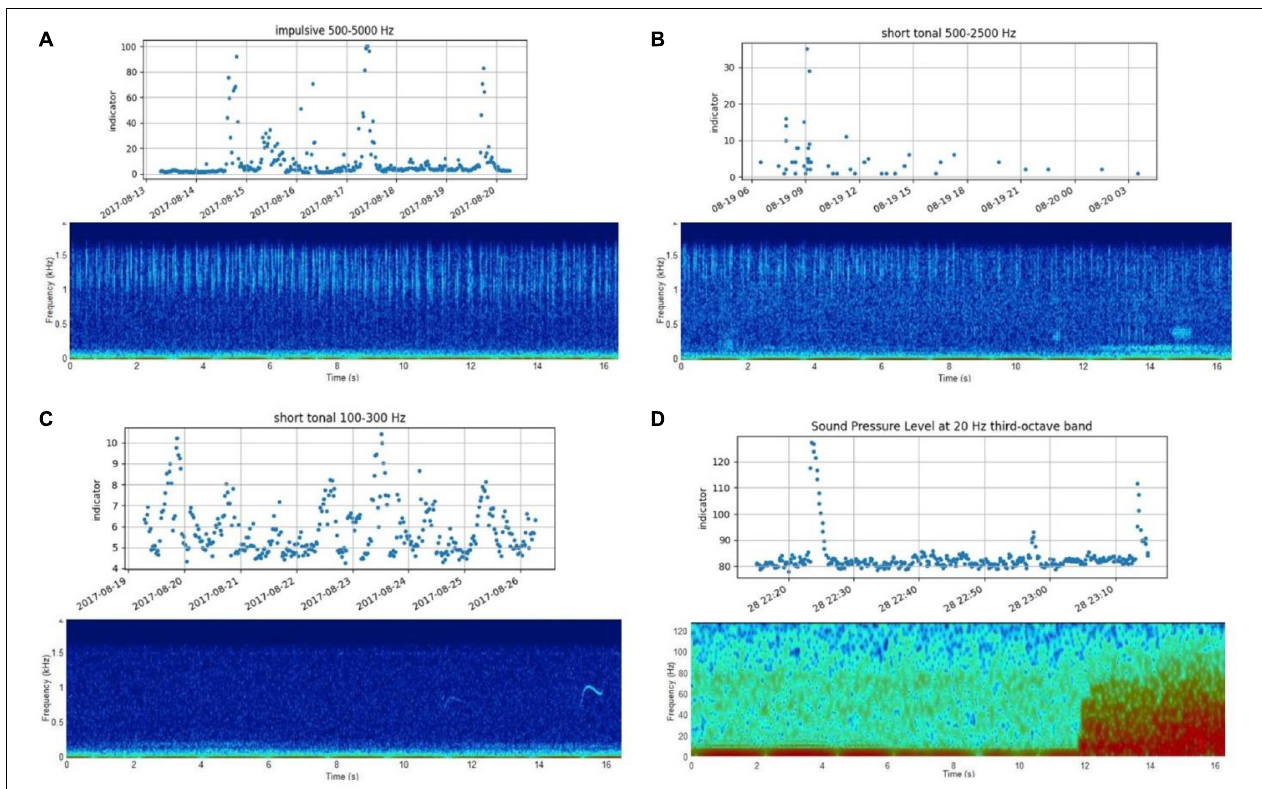
FIGURE 9 | Examples of acoustic events, each panel in this figure shows first in the dotted graphic the output of the data processing over almost 16.3 s segments with one dot per segment, for a particular detector or for example the sound level in a particular band. The second image in each panel is a spectrogram which shows a particular segment of interest (high detector value or high sound level): (A) the output of the impulse detector between 500 and 5,000 Hz and in the spectrogram signals which might be the lower part of sperm whale biosonar Play example A: (http://lido.listentothedeep.com/acoustics/index2.php? web=dataanalysis&rebuild&ts=1502604900&spp=0&width=0&time_unit=days&time_value=7&draw=67073:16843265:0:0-&grouping=none&metric_id=1 &trend=0&spectrogram_timestamp=1502961658&spectrogram_platform=67073&spectrogram_segment=0&spec_id=1&overlay=1). (B) The output of the short tonal detector between 500 and 2,500 Hz which picked up various whistle-like signals Play example B: (http://lido.listentothedeep.com/acoustics/index2.php? web=dataanalysis&rebuild&ts=1503123300&spp=0&width=0&time_unit=days&time_value=1&draw=67073:16843012:0:0-&grouping= none&metric_id=1&trend=0&spectrogram_timestamp=1503133395&spectrogram_platform=67073&spectrogram_segment=1540559007&spec_id=1&overlay=1). (C) The output of a low frequency short tonal detector with a spectrogram showing at the bottom right-side croaker fish sounds Play example C: